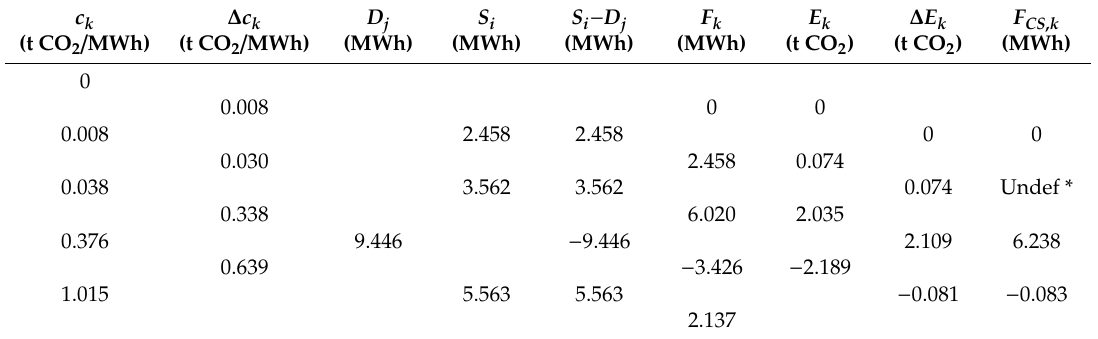
Table 5. Cascade analysis for the low-carbon energy source where not all CO 2 loads are non-negative.